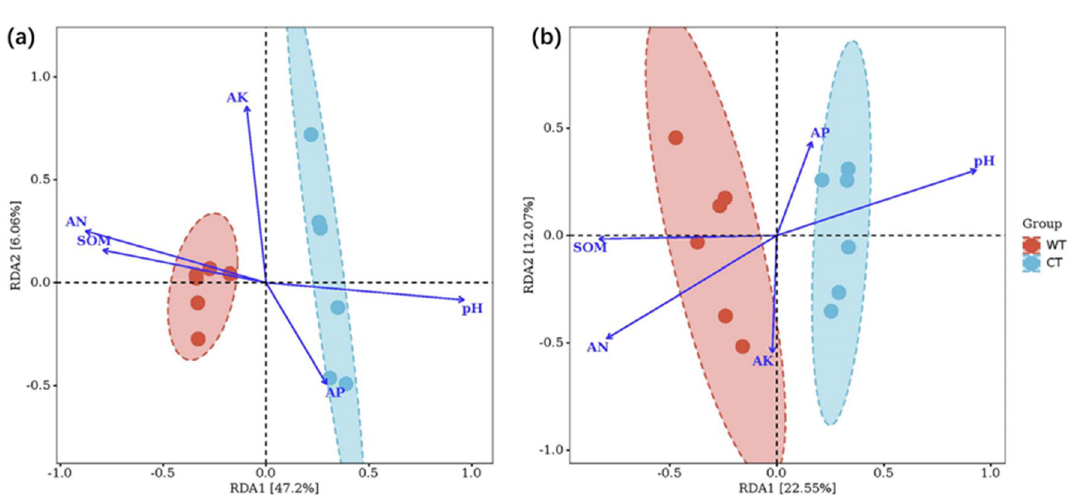
Figure 6. Redundancy analysis (RDA) plot showing the relationship between soil bacterial ( a ) and fungal ( b ) community structure and the soil properties explained by soil pH, soil organic matter content (SOM), available nitrogen (AN), available phosphorus (AP), available potassium (AK) under cultivated (CT) and wild conditions (WT). Arrows pointing in the same direction indicate positive correlations, and arrows pointing in opposite directions indicate negative correlations. The arrow length corresponds to the variance explained by the environmental